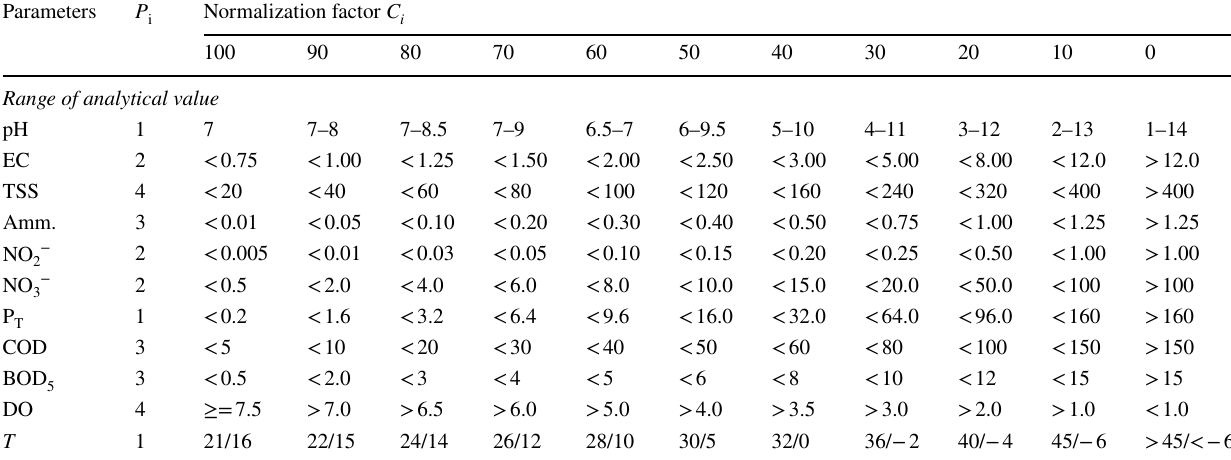
Table 1 Relative weight and normalized values of the parameters entering in the calculation of WQI